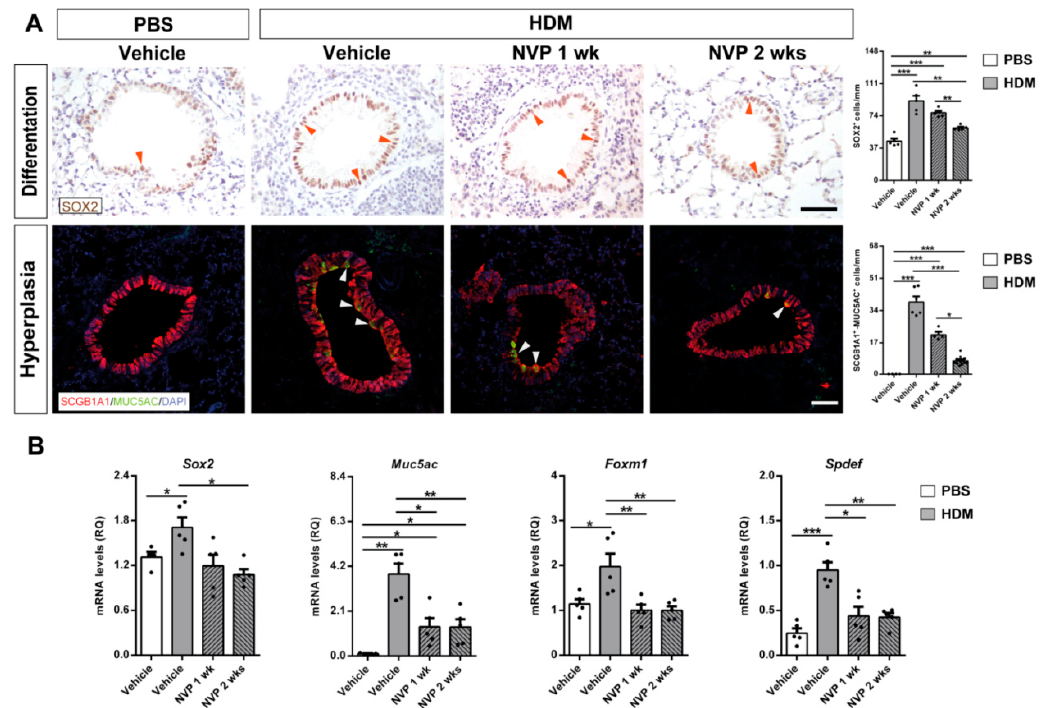
Figure 6. Pharmacological targeting of IGF1R attenuates bronchial differentiation and goblet cell hyperplasia upon HDM-induced allergy. ( A ) Representative immunostains of proximal airways for SOX2 (bronchial differentiation) (brown; orange arrowheads indicate SOX2 + cells), as well as double immunofluorescent stains for SCGB1A1 (red) (club cell marker) and MUC5AC (green) (goblet cell hyperplasia) (white arrowheads indicate double SCGB1A1 + -MUC5AC + cells). Quantification of SOX2 + and double SCGB1A1 + -MUC5AC + cells per epithelium length (mm) in lung sections from HDM-challenged mice treated with NVP vs. controls ( n = 5–10 mice per group; scale bars: 50 µ m). ( B ) Lung mRNA expression levels of Sox2 (bronchial differentiation) and Foxm1, Spdef and Muc5ac markers (goblet cell hyperplasia) normalized to 18S expression in HDM-challenged mice treated with NVP vs. controls ( n = 5 mice per group). Quantifications in lung sections were performed in 5 different bronchi in a random manner. Data are expressed as mean ± SEM. * p < 0.05; ** p < 0.01; *** p < 0.001 (Mann–Whitney U test or Student´s t -test for comparing two groups and Kruskal–Wallis test or ANOVA multiple comparison test for grouped or multivariate analysis).